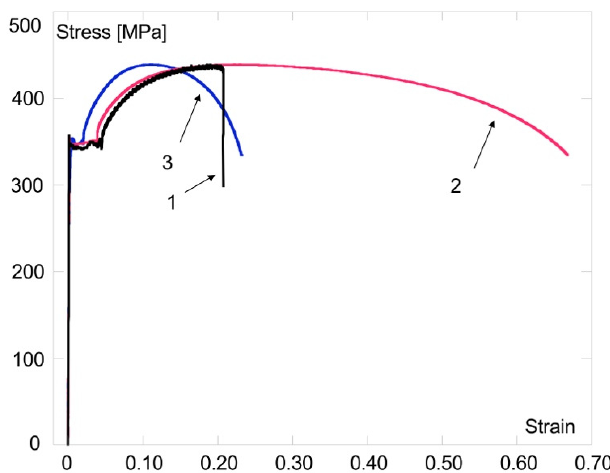
Figure 8. Engineering stress–strain curves of: 1, full CS flat specimen (clip-on extensometer data); 2, CS region of the LW joint (E2 virtual extensometer data); 3, CS-SS joint (E1 virtual extensometer data).